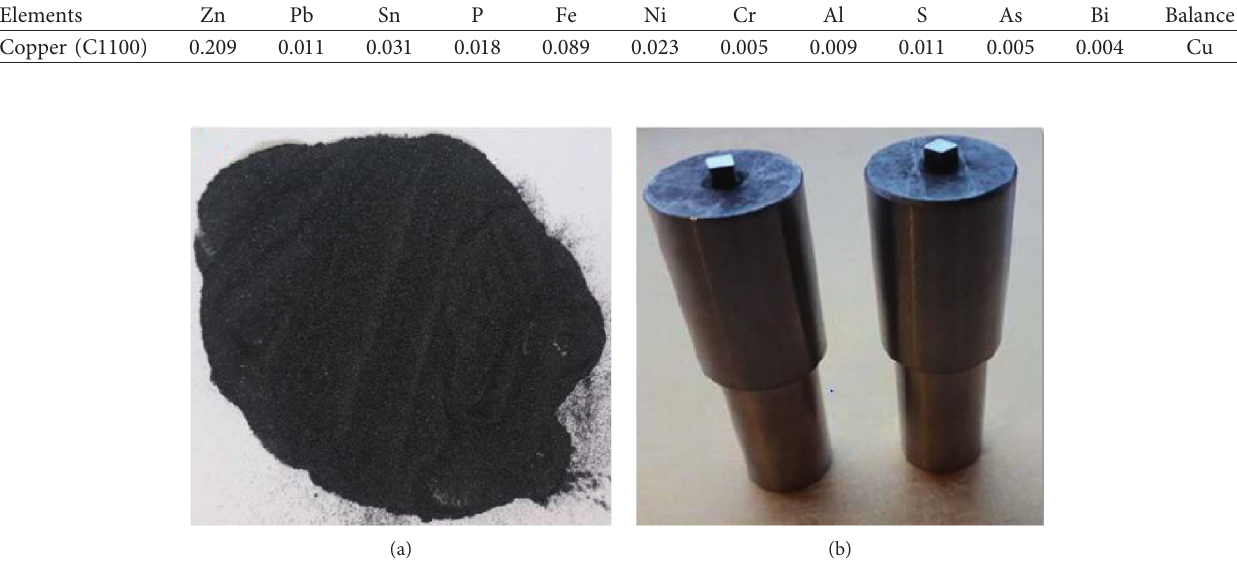
Figure 1: Schematic view of the boron carbide particles and the FSW tool. Table 2: Thermal and mechanical properties of the copper (C1100)